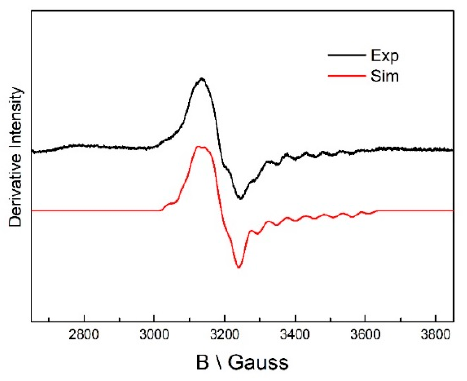
Figure 3. EPR spectrum in the reaction with 4-thialysine with dAPLP/5,6-LAM. Experimental pa- rameters: microwave frequency, 9.487 GHz; power, 2 mW; modulation, 8 G at 100 kHz; T = 80 K. Simulation: g Co = [2.278 2.227 2.000], g radical = [2.014 2.01 2.004], Euler’s angle = [22° 28° − 5°]; A Co = [20 3 110] G; A N = 19 G; J = 8178 G; D = − 168 G; E = 0; Euler angle = [31° 48° 5°]; line width = 18 G.